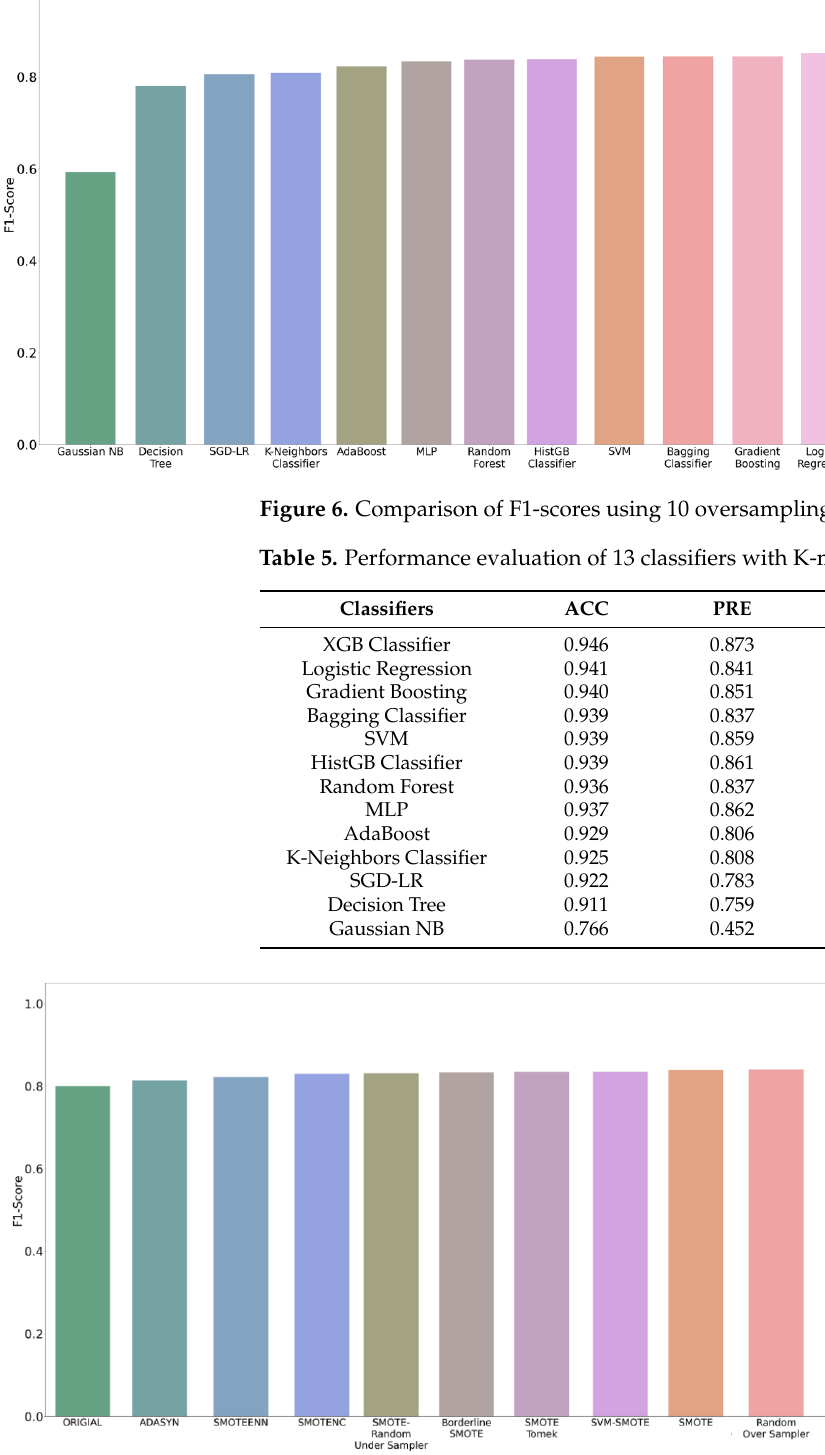
Figure 7. Comparison of F1-score of 13 classifiers with K-means SMOTE.